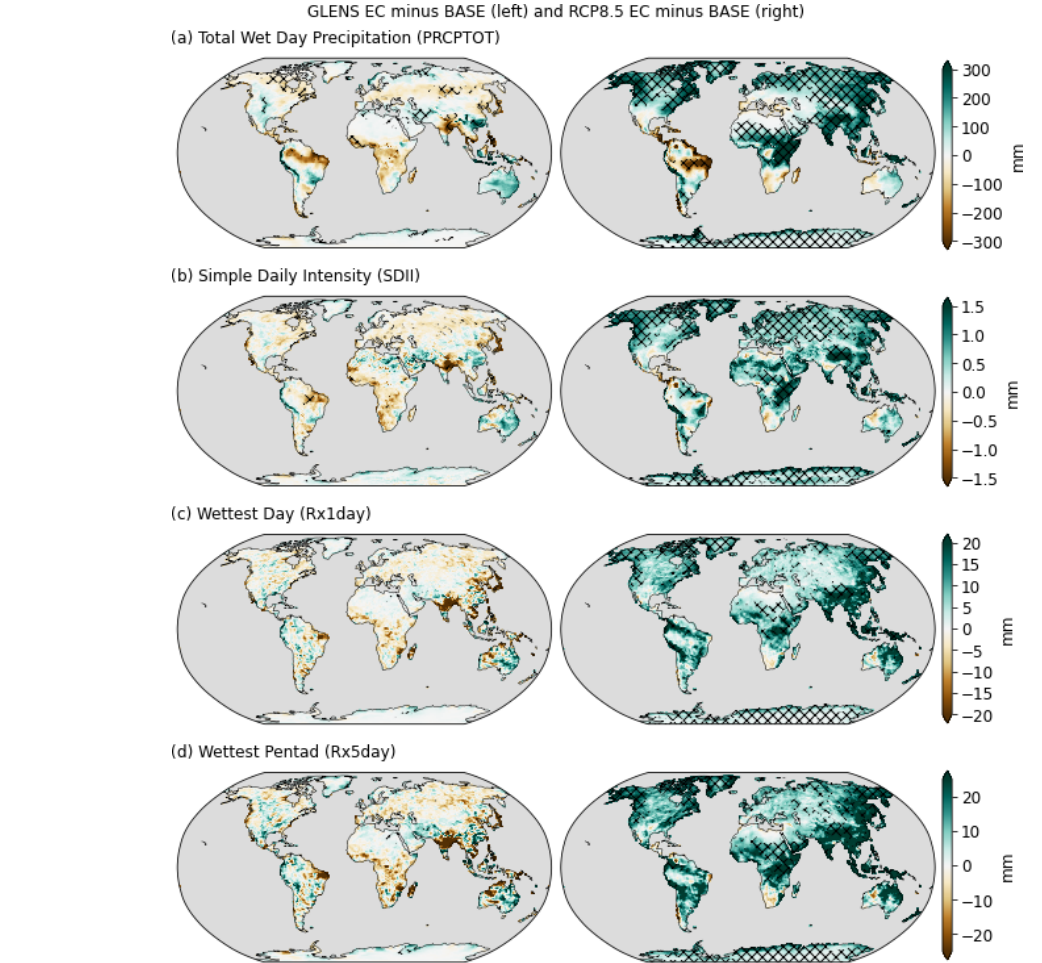
Figure 6. Similar to Fig. 2, but for projected changes in (a) annual precipitation (PRCPTOT), (b) the mean wet day volume (SDII), (c) annual maximum precipitation (Rx1day), and (d) annual wettest pentad (Rx5day). Hatching indicates significance at the 5% test level using the Student’s t